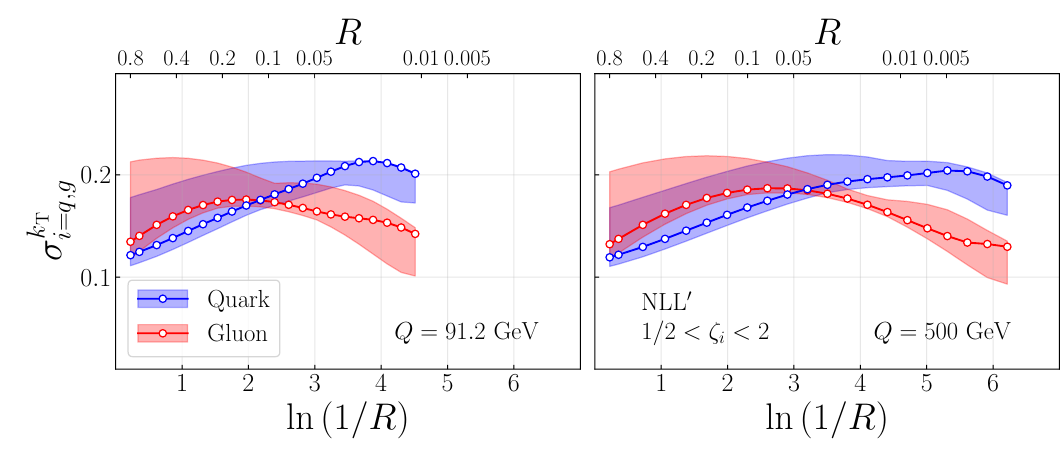
of the energy loss of e + e − hemisphere leading jets for quark and gluons. Figure 10 . Variance σ k T i As in figure 9, we choose a k -type jet algorithm, two initial reference scale of Q = 91 . 2 GeV and T 500 GeV and we plot the result as a function of the jet